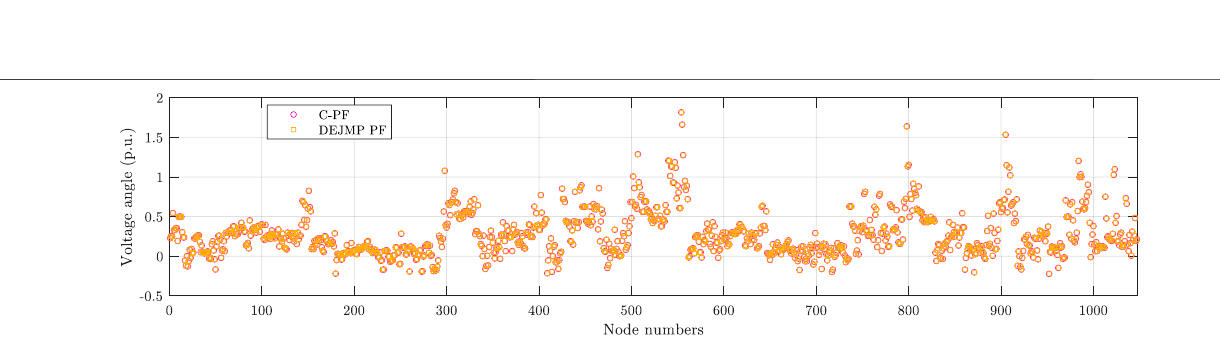
FIGURE 5 | the voltage angle obtained by DEJMP-based PF and C-PF on S-1047 bus systems.